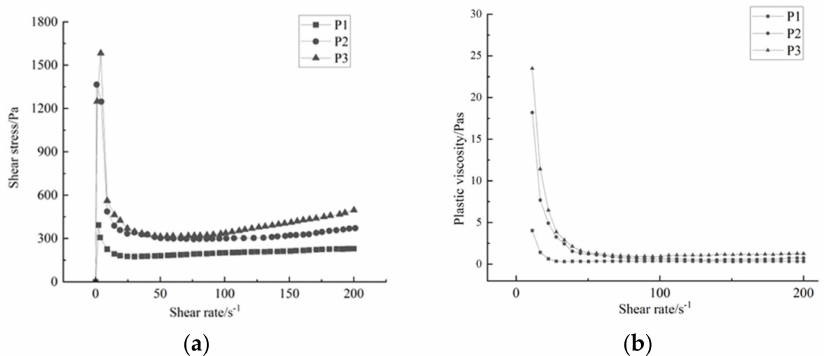
Figure 7. Rheological property curve of ECC prepared with different types of fly ash: ( a ) shear stress curve; ( b ) plastic viscosity